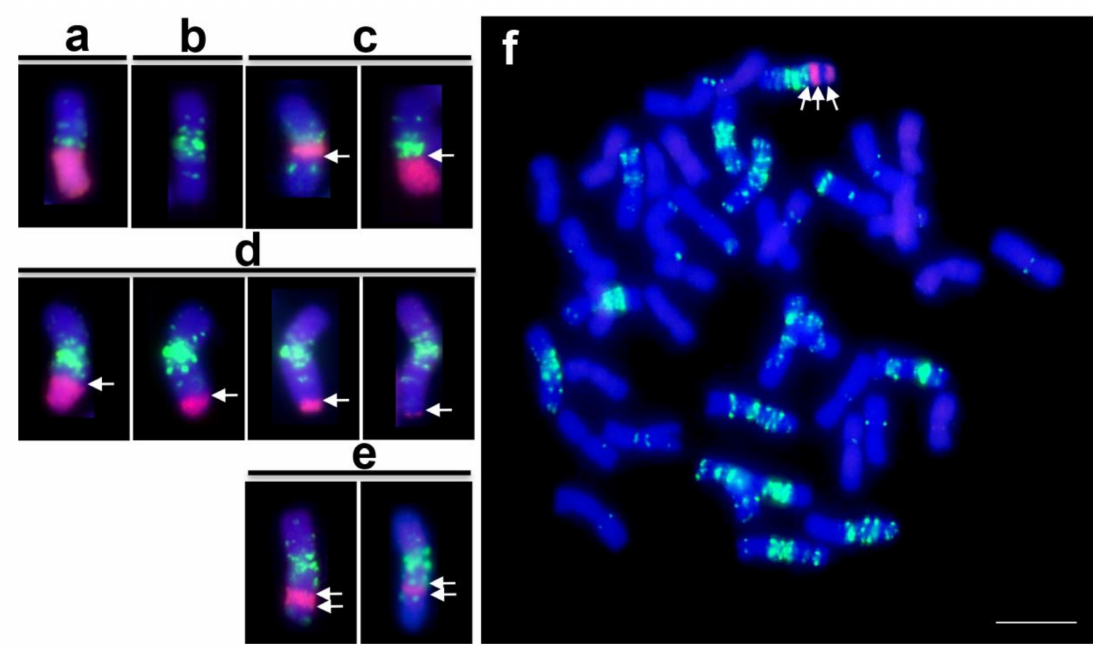
Figure 3. Hpp-5M g ph1bph1b- induced homoeologous wheat- Th. intermedium recombinants. ( a ) RobT T7BS · 7S#3L; ( b ) chromosome 7B; ( c – f ) recombinant chromosomes derived from Hpp-5M g ph1bph1b - induced homoeologous recombination between (T7BS · 7S#3L) and (7B); ( c ) COs in proximal region; ( d ) COs in interstitial and distal regions; ( e , f ) recombinants having more than two CO sites. Four recombinants involving translocation at distal region are not shown in the figure. Total genomic DNA of Th. Intermedium was used as a probe to detect the Th. Intermedium chromatin (red fluorescence). GAA repeats (green fluorescence) were used to identify chromosome 7B of wheat. Bar = 10 µ